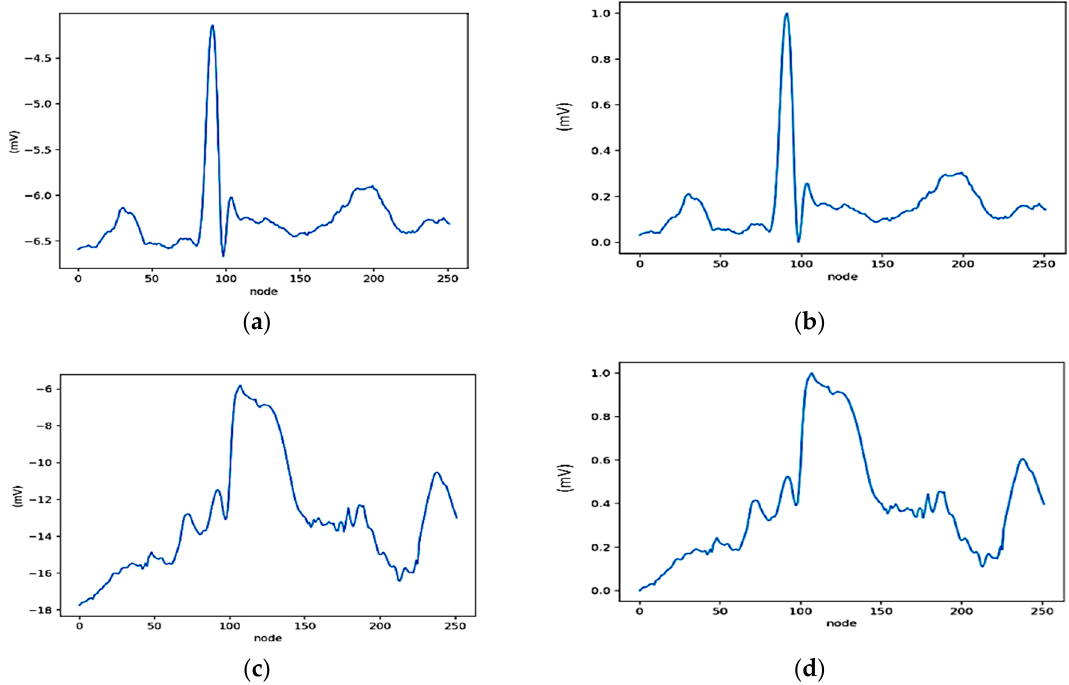
Figure 5. The sample of normalized beats in record 119. ( a ) ECG signal 24 dB before normalization, ( b ) ECG signal 24 dB after normalization, ( c ) ECG signal − 6 dB before normalization, ( d ) ECG signal − 6 dB after normalization.